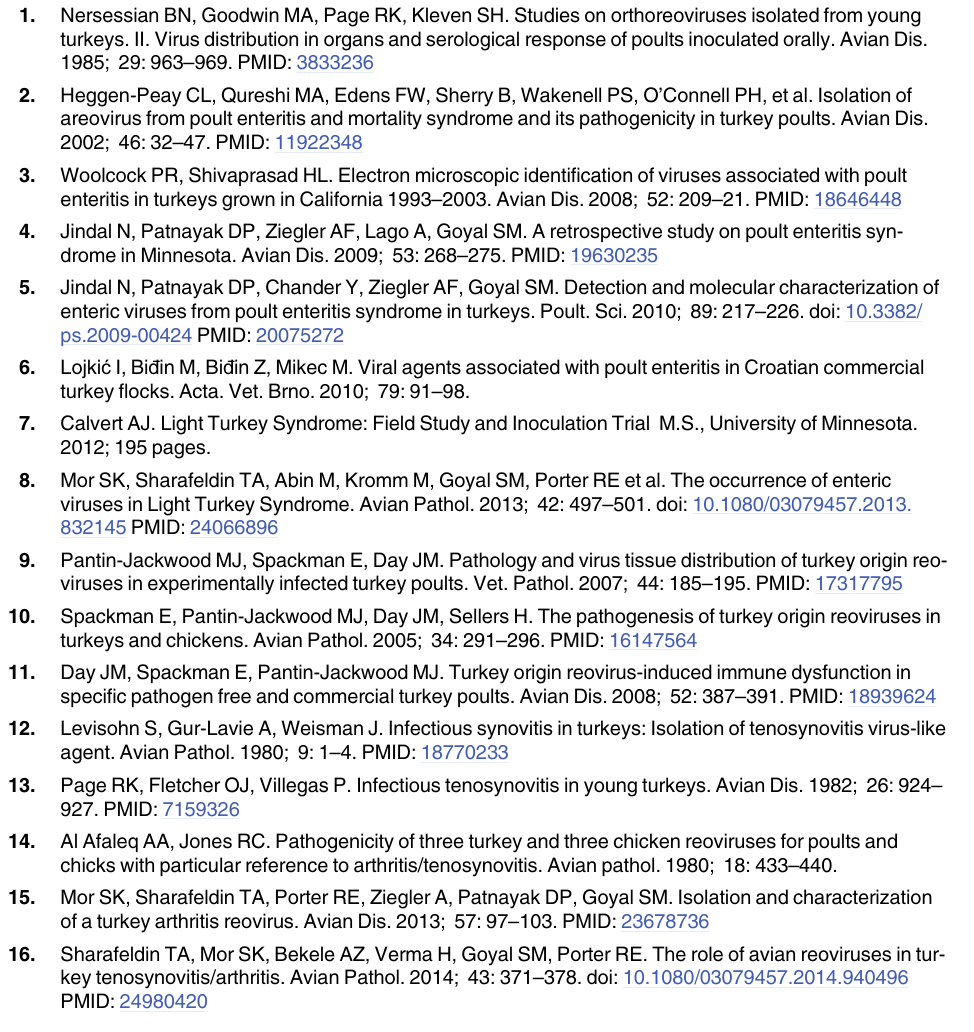
S2 Table. Means and standard deviations of different cytokines fold changes in duodenum controls at different time points post